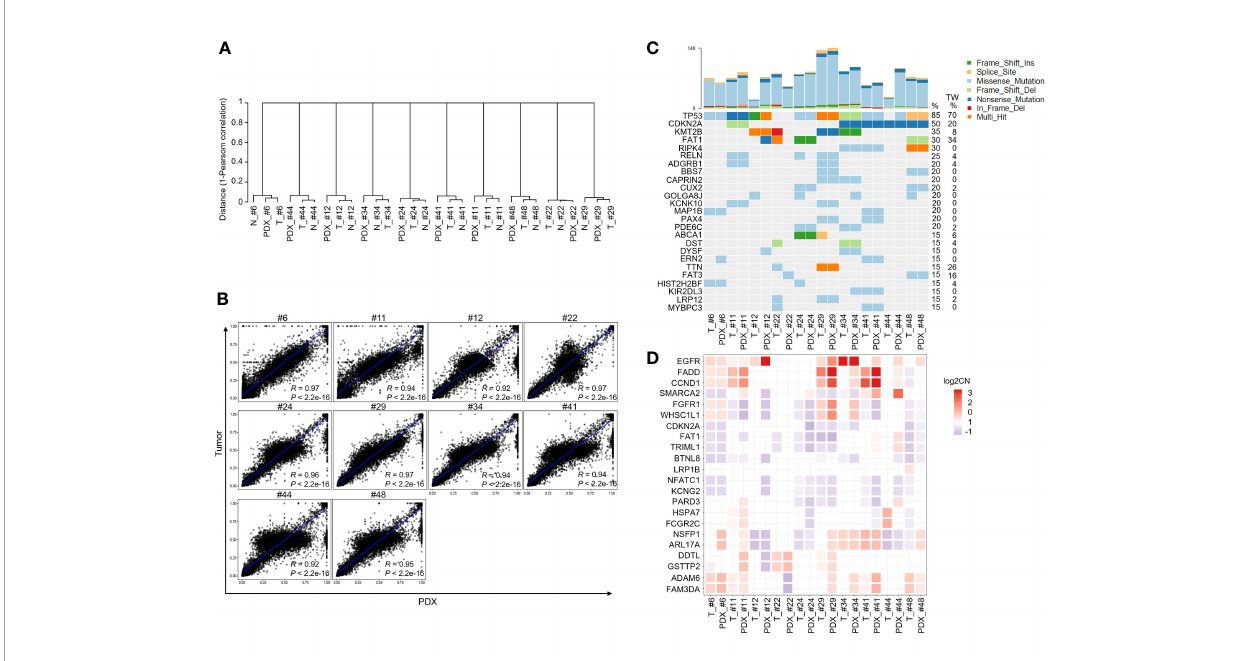
FIGURE 4 | Comparison of genomic landscape alterations in OSCC patients and PDXs. The genomic landscapes of paired normal tissues, tumor tissues, and xenografts were determined by whole-exome sequencing. (A) Unsupervised clustering analysis of variant allele frequency (VAF) distributions in paired normal tissues, tumor tissues, and their matched P1 PDXs. (B) The correlation coef fi cients of variants between primary tumors and matched PDXs were calculated. (C) The comparison of total genomic mutation counts in OSCC patients and their matched PDXs was shown in the upper panel. The y-axis shows the number of mutation events in the WES data. Heatmap representation of genes frequently mutated between OSCC patients and their matched PDXs. The numbers in the left lane represent the mutation frequencies of speci fi c genes in these 10 paired specimens and in our previously published OSCC cohort (TW; n = 50). (D) Heatmap representation of the copy number variation (CNV) of targeted genes in OSCC patients and their matched